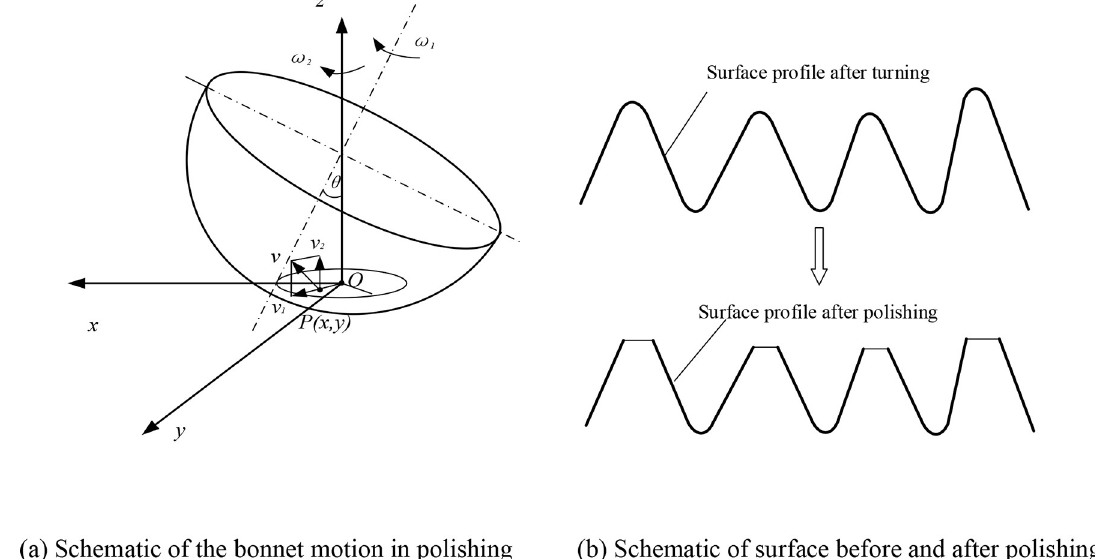
Fig 3. Schematic of polishing